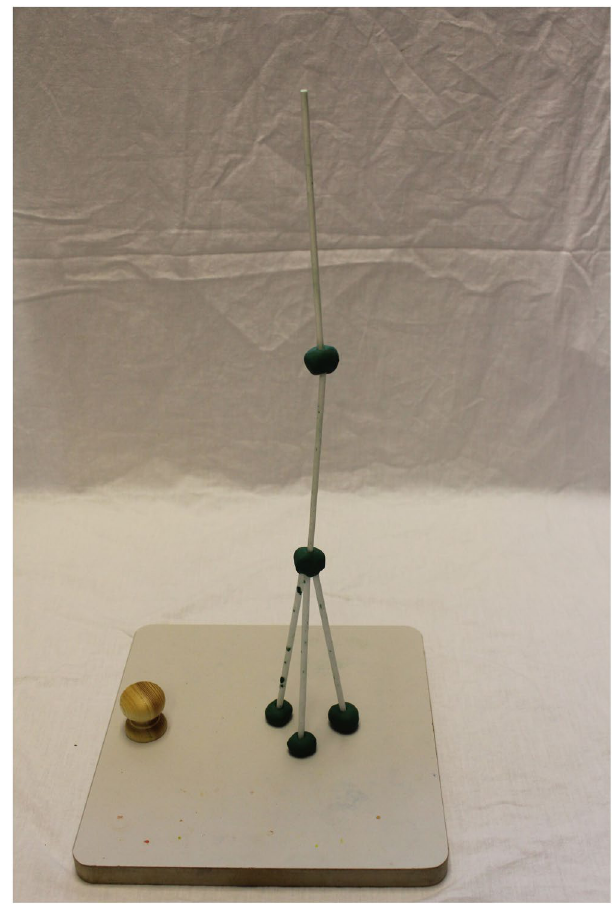
Figure 1. Demonstration tower (tripod). Example of the cumulative technological design children in the demonstration conditions were presented with (h = 46